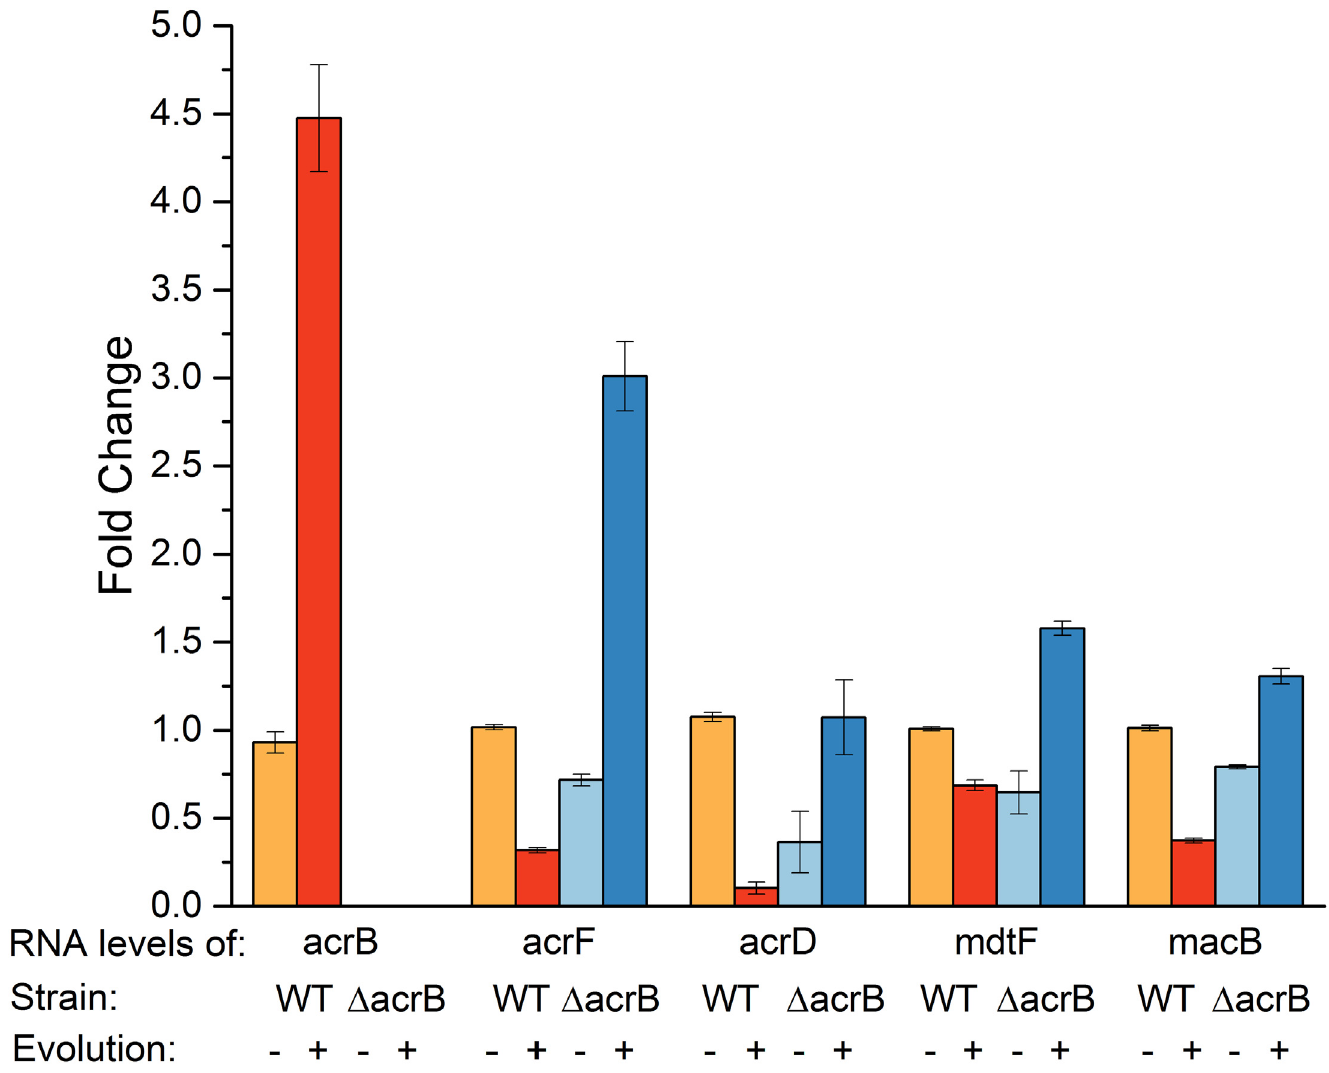
Fig 3. Expression of TolC dependent transporters increases during evolution in the Δ acrB strain. The levels of RNA transcripts of the genes acrB , acrD acrF , mdtF and macB were determined in WT-EV18 and Δ acrB